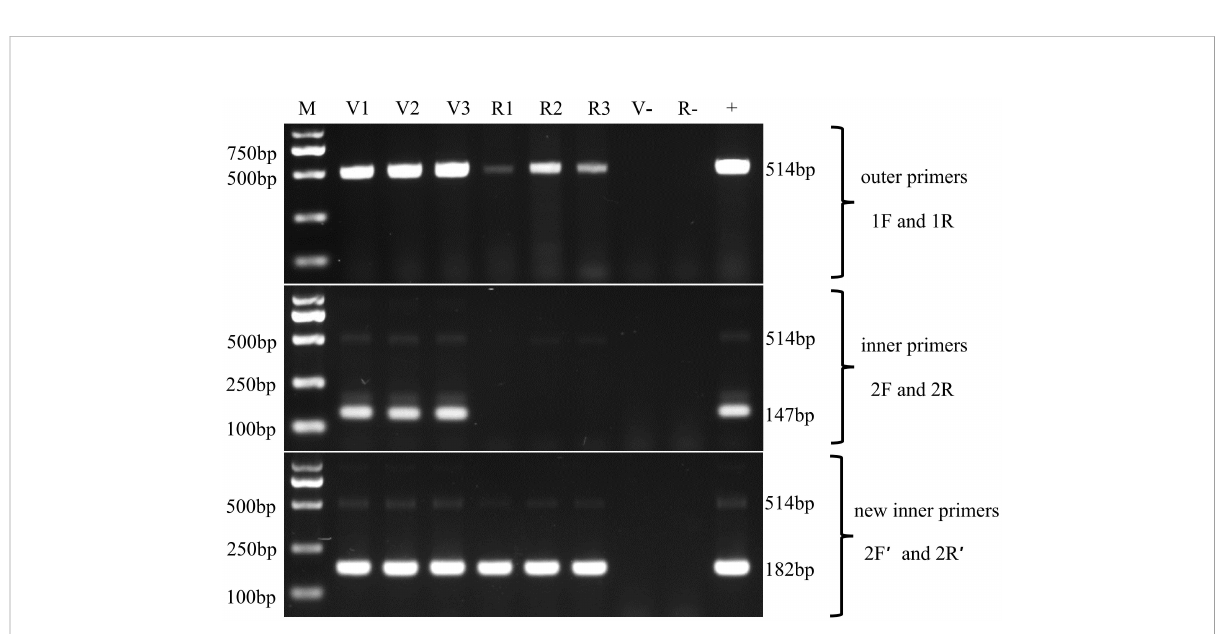
FIGURE 4 Nested PCR for the detection of the two EHP stains in Litopenaeus vannamei and Macrobrachium rosenbergii by using the SWP2F/2R primers and SWP2F ′ /2R ′ primers, respectively. Lanes V1~V3: the hepatopancreatic DNA of EHP Lv -infected Litopenaeus vannamei ; Lanes R1~R3: the hepatopancreatic DNA of EHP Mr -infected Macrobrachium rosenbergii ; M: molecular weight marker; +: positive control, SWP1 gene plasmid DNA; v-: negative control, the hepatopancreatic DNA of healthy Litopenaeus vannamei , R-: negative control, the hepatopancreatic DNA of healthy Macrobrachium rosenbergii